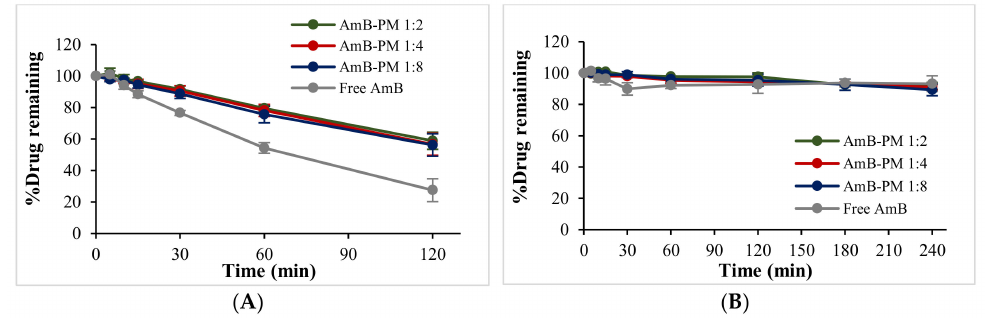
Figure 3. %Drug remaining of AmB-PM and free drug in ( A ) fasted state simulated gastric fluid (FaSSGF) pH 1.6 and ( B ) fasted state simulated intestinal fluid (FaSSIF) pH 6.5 ( n =